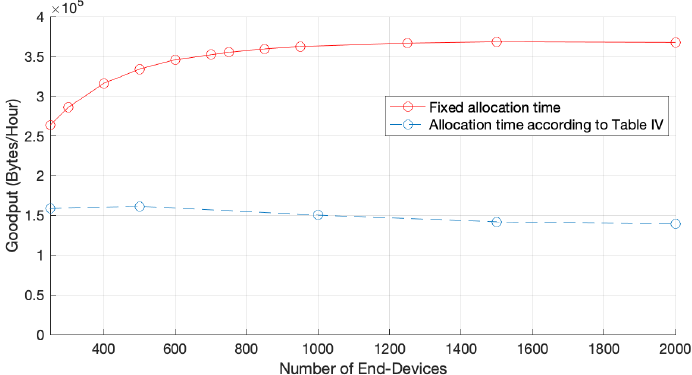
Figure 11. Network goodput for 1 GW and fair channel allocation